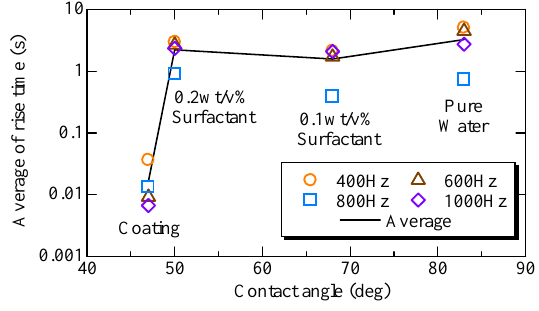
Figure 10. Relationship between the rise time and the contact